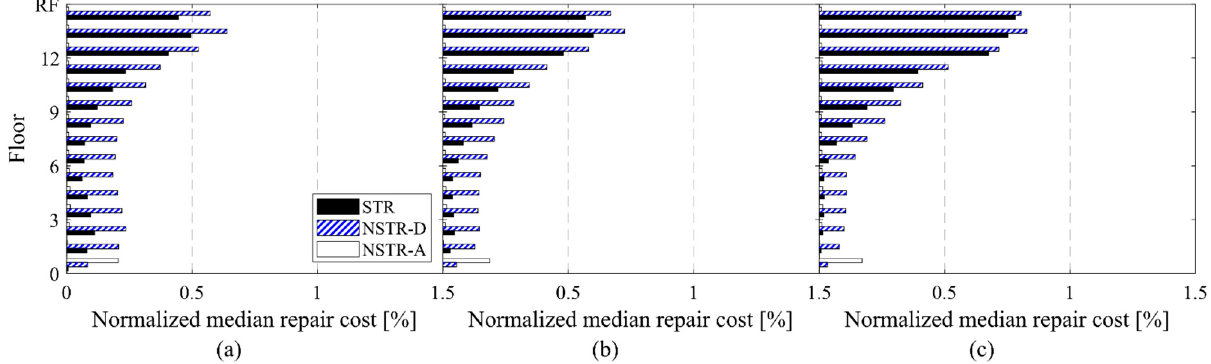
Figure 11. Normalized median repair cost of 15-story steel OMFs at DBE hazard level: ( a ) W0-OMF; ( b ) W44-OMF; ( c ) W51-OMF.